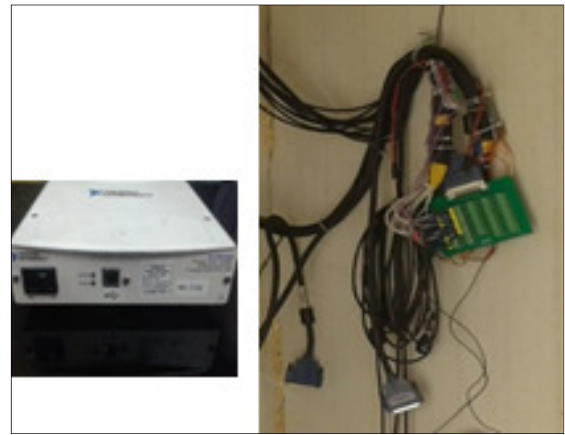
Fig. 8. National instrument data acquisition.